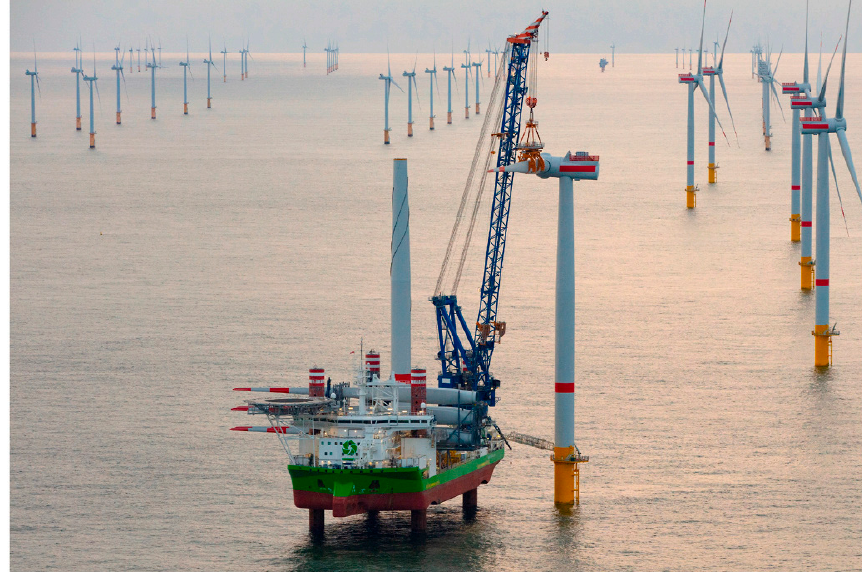
Figure 4. Wind power operation and maintenance platform [24].